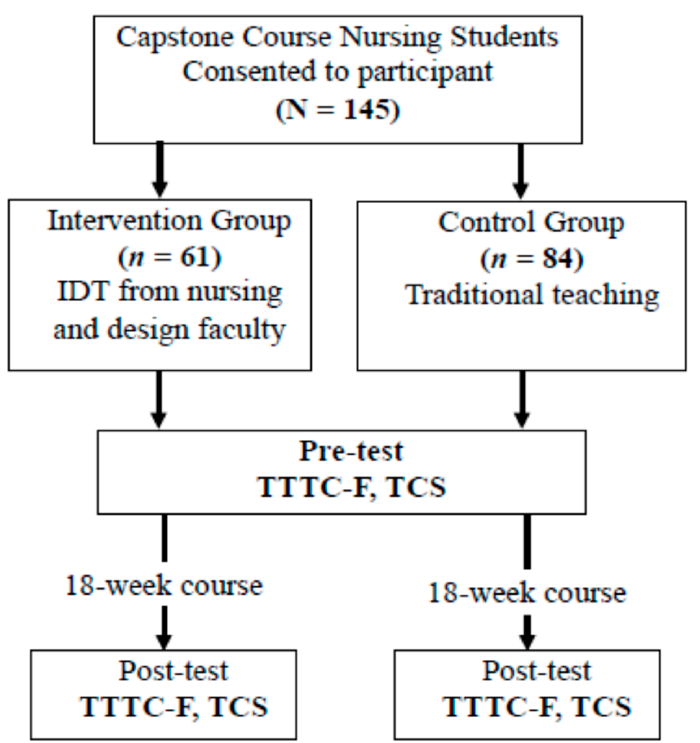
Figure 1. Flowchart of interdisciplinary teaching intervention in teaching creativity and the control group.